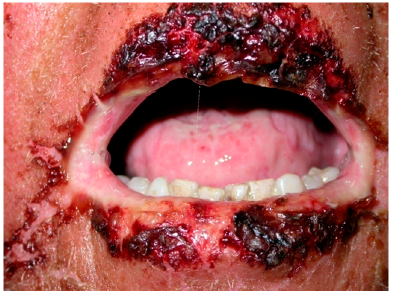
Figure 2. PNP peri-oral lesions. Ulceration with crusting over the peri-oral region and lips.